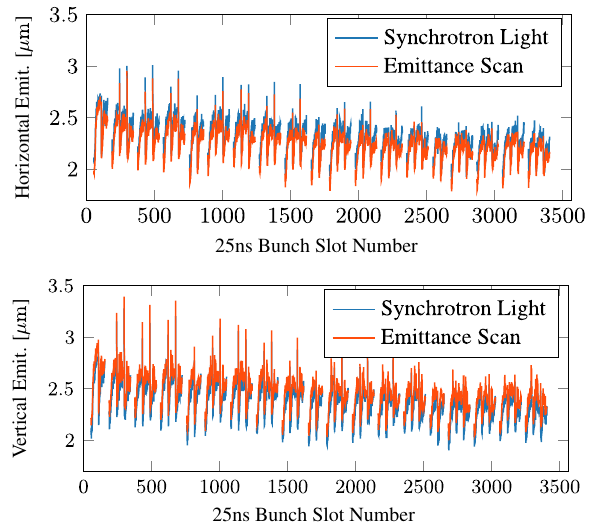
FIG. 11. The bunch-by-bunch emittances of all 2556 bunches in the LHC (fill 6054).